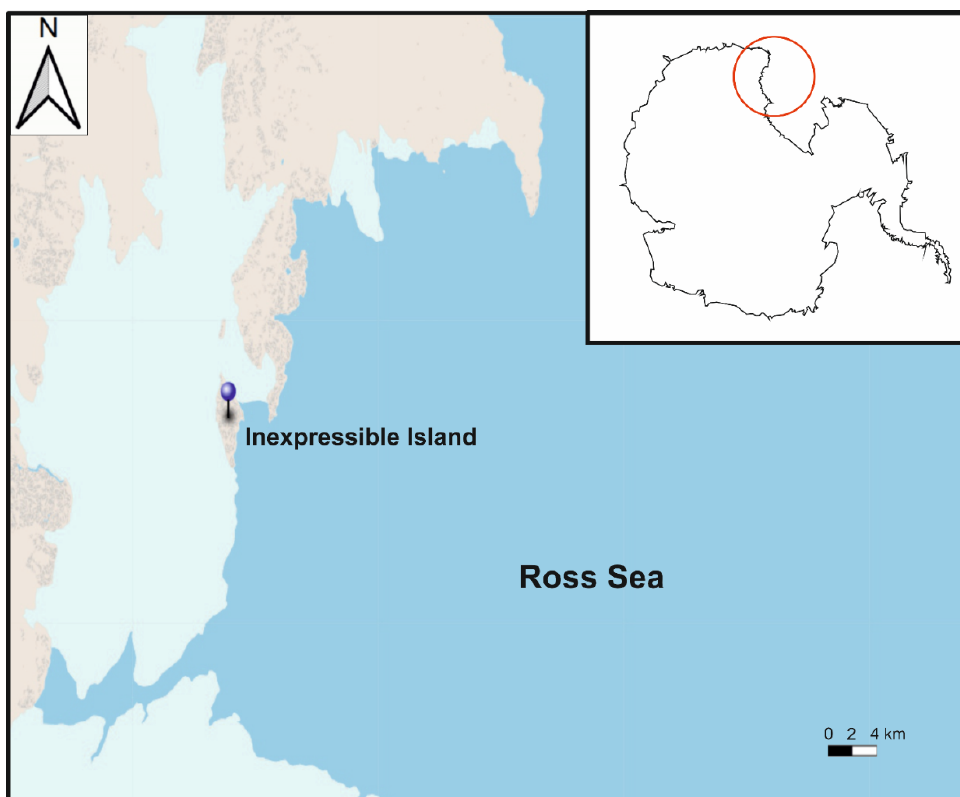
Figure 1. Map of Inexpressible Island, the sampling site is defined by the blue pin. The red circle indicates the location of Terra Nova Bay.